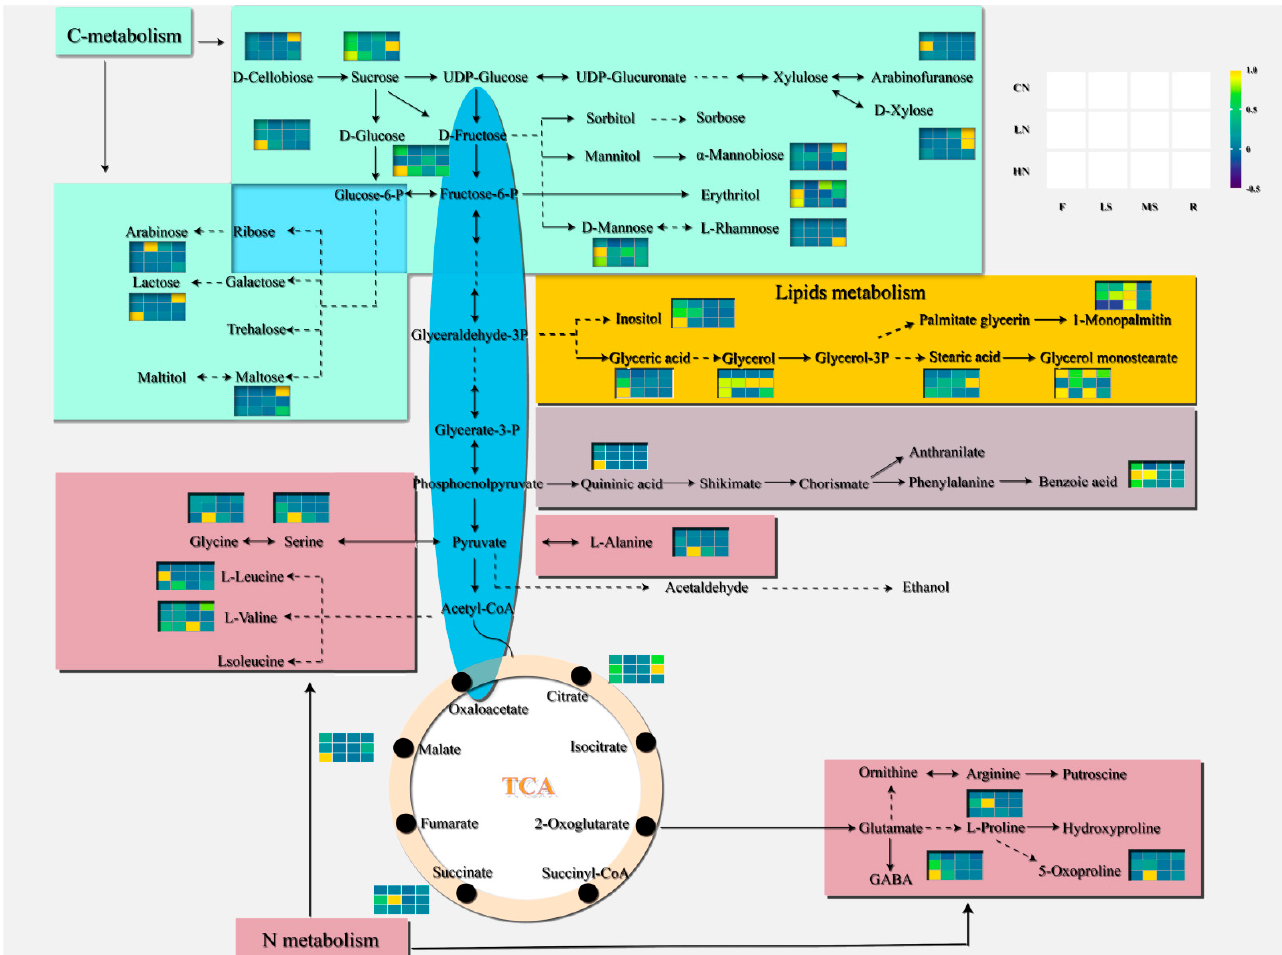
Figure 6. Changes of metabolites in Bupleurum under nitrogen stress are mapped to metabolic pathways. The yellow rectangle means that the content of metabolites is significantly up − regulated; the blue rectangle means that the content of metabolites is significantly down − regulated; the green rectangles mean that there is no significant difference in metaboites content. In each box, every row represents nitrogen treatment (upper row: CN; middle row: LN; lower row: HN), and every column means various organs (F: flower; LS: lateral shoots; MS: main shoots; R: